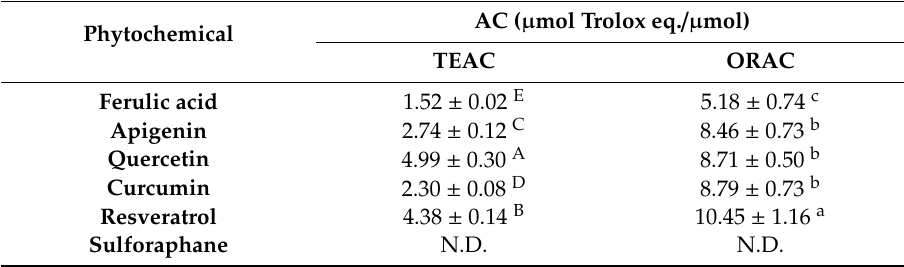
Table 1. Antioxidant capacity (AC) of di ff erent phytochemicals, as evaluated by Trolox Equivalent Antioxidant Capacity (TEAC) and Oxygen Radical Absorbance Capacity (ORAC)